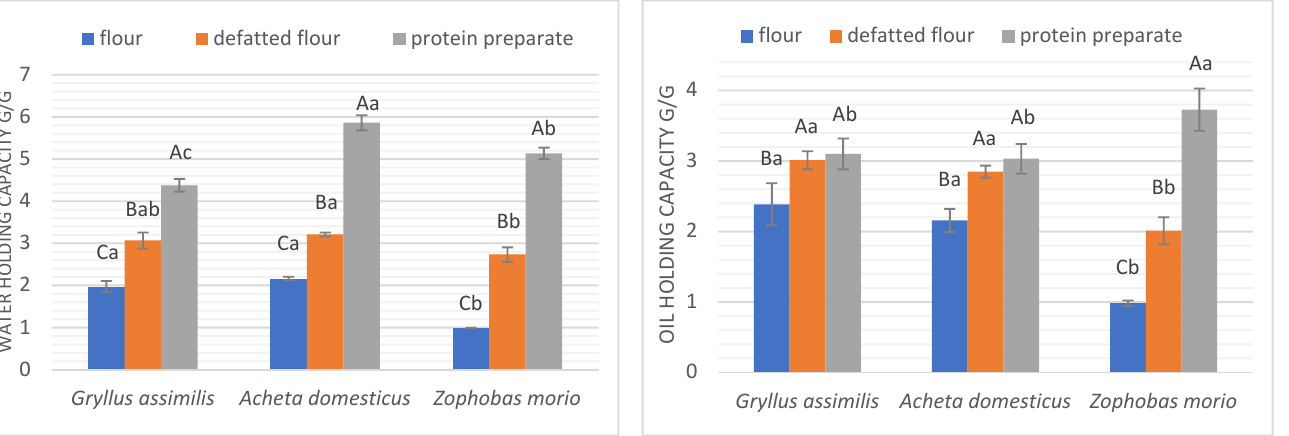
Figure 2. Absorbing properties of studied insect forms. ( a ) Water holding capacity (g/g); ( b ) oil holding capacity (g/g). Different letters in the same form of an insect (flour, defatted flour, protein preparation) indicate a significant difference ( p < 0.05). Different capital letters in the same insect species indicate a significant difference ( p < 0.05).